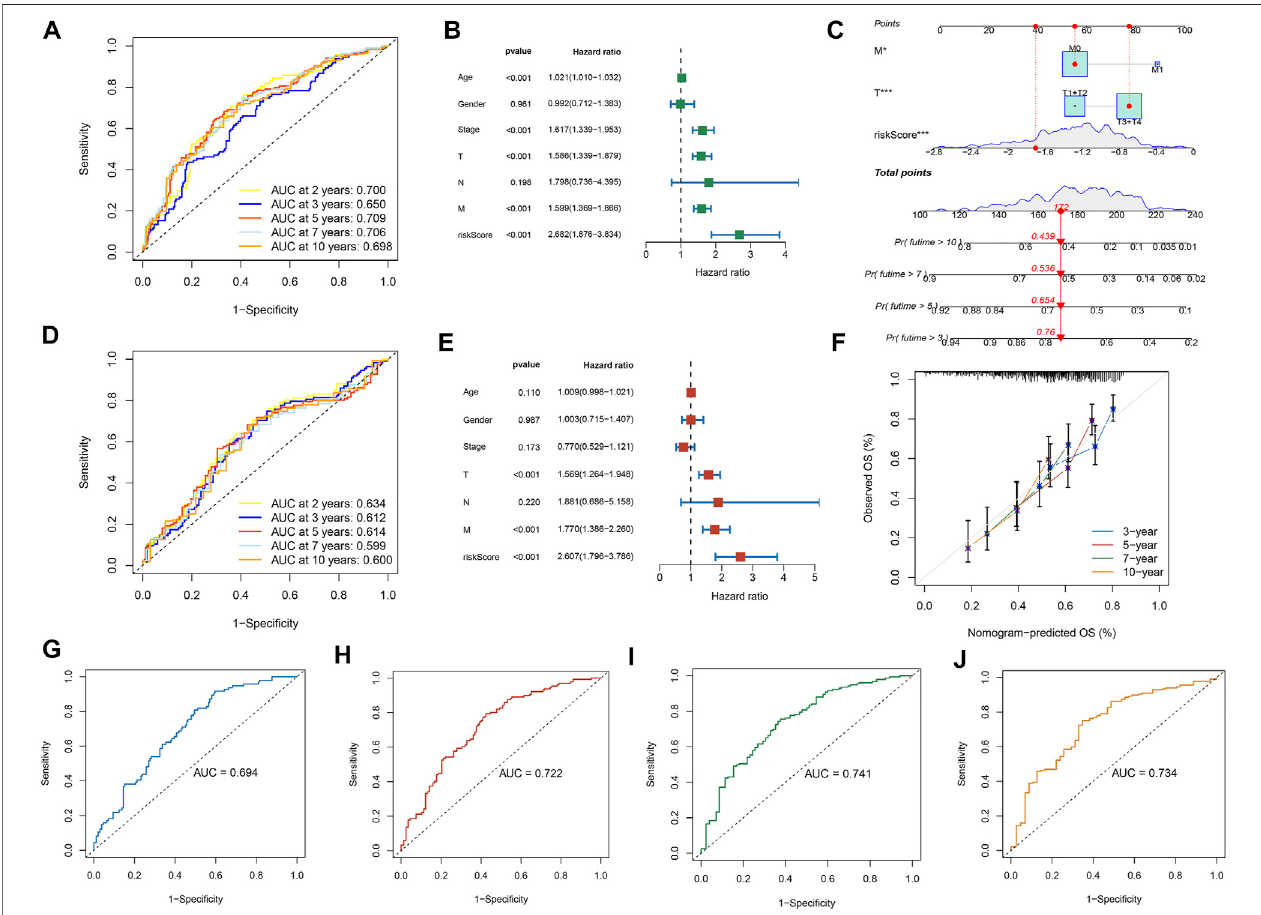
FIGURE 4 | The risk model performance. (A,D) The prognostic model ROC curves in TCGA and GEO cohorts. The univariate (B) and multivariate (E) Cox regression analysis of factors with OS. Construction of the nomogram model: (C) Nomogram predicting 3-, 5-, 7- and 10-year OS for SKCM patients. (F) Nomogram model calibration curves. (G – J) The nomogram ’ s time-dependent ROC curves predict 3-, 5-, 7-, and 10-year